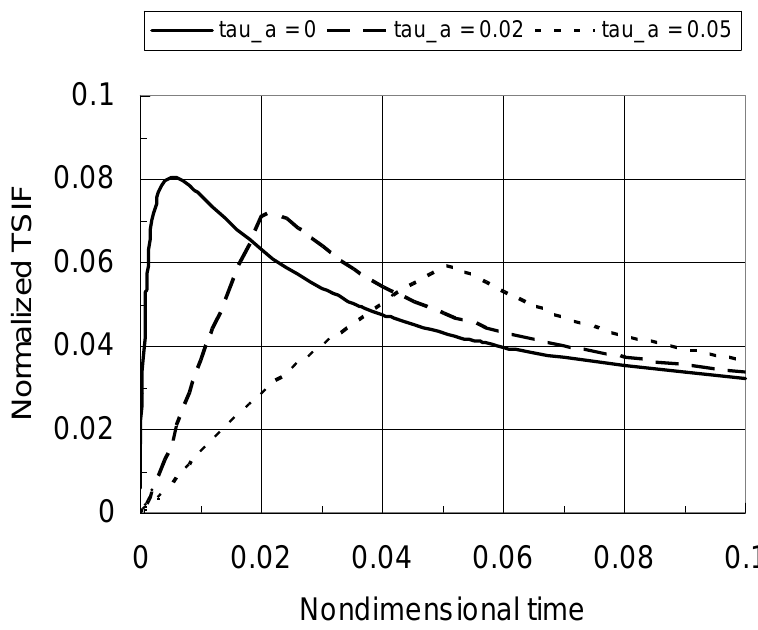
Figure 3. Normalized TSIF versus nondimensional time for a TiC/SiC FGM ( a / b = 0.1, p =